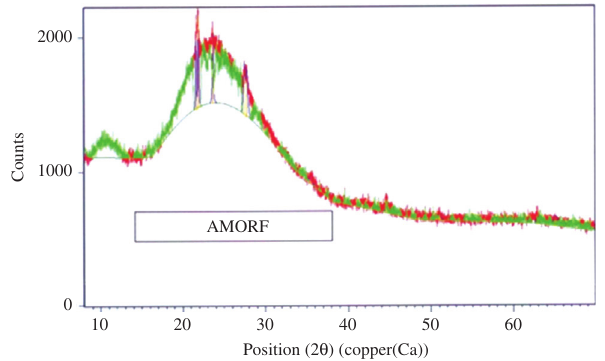
Figure 1 X-ray diffraction pattern of Hasankale pumice.